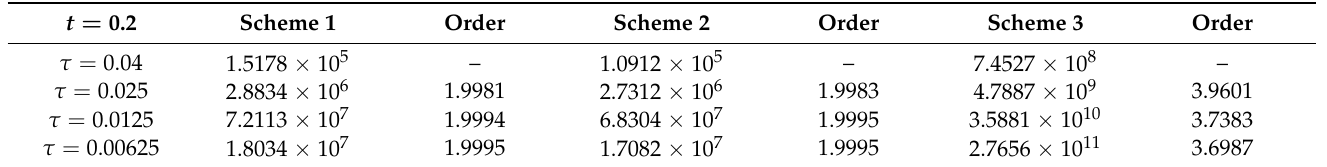
Table 2. The L ∞ errors and the order of convergence of three different schemes with h = 0.2 and different time steps at t = 0.2.